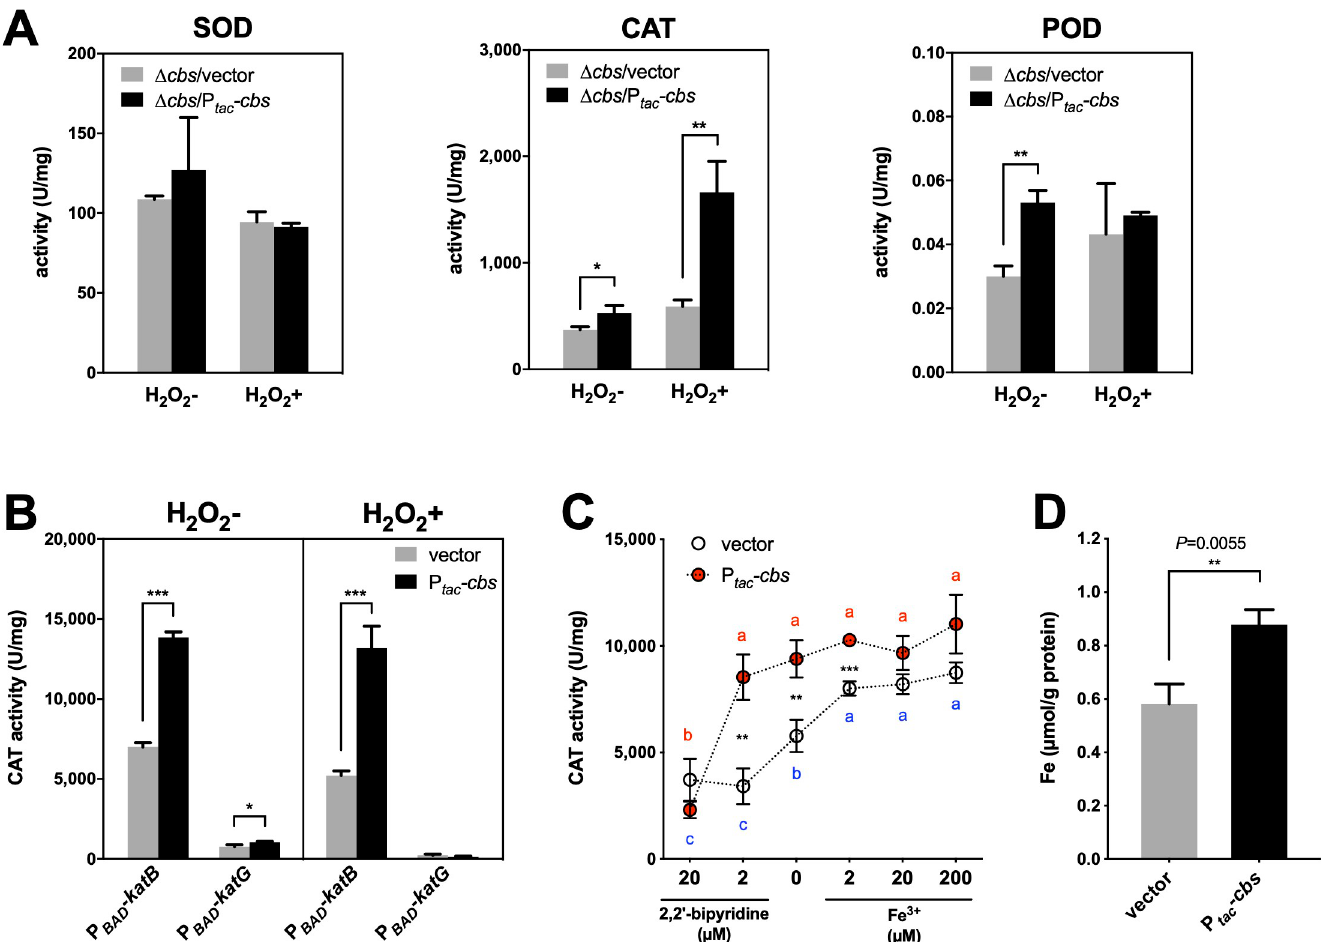
Fig 4. CBS-derived H 2 S enhances catalase activity in V . cholerae , which relates to the facilitation of cellular iron content. (A). Contribution of superoxide dismutases, catalases and peroxidases expression to enzymatic activity in H 2 O 2 detoxification. Superoxide dismutase (SOD), catalase (CAT) and peroxidase (POD) activity in crude extracts of cbs -deficient ( Δ cbs /vector) and overexpressed ( Δ cbs /P tac -cbs ) cells. Cells were grown in M9 minimal medium (M9 salts plus 2 mM MgSO 4 , 0.1 mM CaCl 2 , and 0.2% casein acid hydrolysate as sole carbon source), containing 200 μ M of IPTG, and challenged with or without H 2 O 2 (1 mM, 20 min) at their mid-log phase. Values expressed are means ± S.D. from three experiments. Significance was determined separately for the H 2 O 2- and H 2 O 2+ samples by t -test; p -value: � , < 0.05, �� , < 0.01. (B). Impact of cbs expression on the catalase activity of KatB and KatG, respectively. katB and katG was separately expressed under P BAD inducible promoter in the triple-deletion mutant of cbs , katB and katG . Catalase activity in crude extracts of samples with induced cbs expression (P ) was compared with tac -cbs that of cbs -deficient cells (pMal-c2x vector). Bacterial cultures were treated with or without H 2 O 2 (1 mM, 20 min) before collection. Values are means ± S.D. from three experiments. Significance was determined by t -test; p -value: ns, not significant, � , < 0.05, ��� , < 0.001. (C). CBS-derived H 2 S helps to retain the catalase activity of KatB under iron-deficient conditions. Cells were grown in M9 medium containing 0.2% casein acid hydrolysate as the sole carbon source and induced with 0.5 mM IPTG and 0.02% arabinose. Iron chelator 2,2’-bipyridine or FeCl 3 was added to monitor the iron content of the medium as indicated. Catalase activity in crude extracts of Δ cbs Δ katB Δ katG cells, containing P BAD -katB , and having either P tac -cbs ( cbs + ) or vector control ( cbs - ), was examined. Significance was determined by two-way ANOVA from the data of three independent experiments. Significant differences in the mean rank of the catalase activity of each strain at different iron levels are shown in alphabetical order ( cbs - , blue letters; cbs + , red letters), with the same letter indicating a p -value > 0.05. The significant differences between cbs - and cbs + strains at certain 2,2’-bipyridine concentrations were also indicated; p -value, �� , < 0.01, ��� , < 0.001. (D). Impact of cbs expression on the iron content in KatB proteins. Hig-tagged V . cholerae KatB was expressed under pBAD promoter in triple-deletion mutant of cbs , katB and katG , with (P - cbs ) or without (vector) additional cbs tac expression. Strains were cultured and induced in M9 minimal medium (M9 salts plus 2 mM MgSO 4 , 0.1 mM CaCl 2 , and 0.2% casein acid hydrolysate as sole carbon source). Purified but not desalted KatB protein samples were subjected to quantification of iron content based on chromogenic reaction with ferrozine (cat. number R22185, Shanghai yuanye Bio-Technology). Values expressed are means ± S.D. from three experiments. Significance was determined by t -test; p -value: �� , < 0.01.